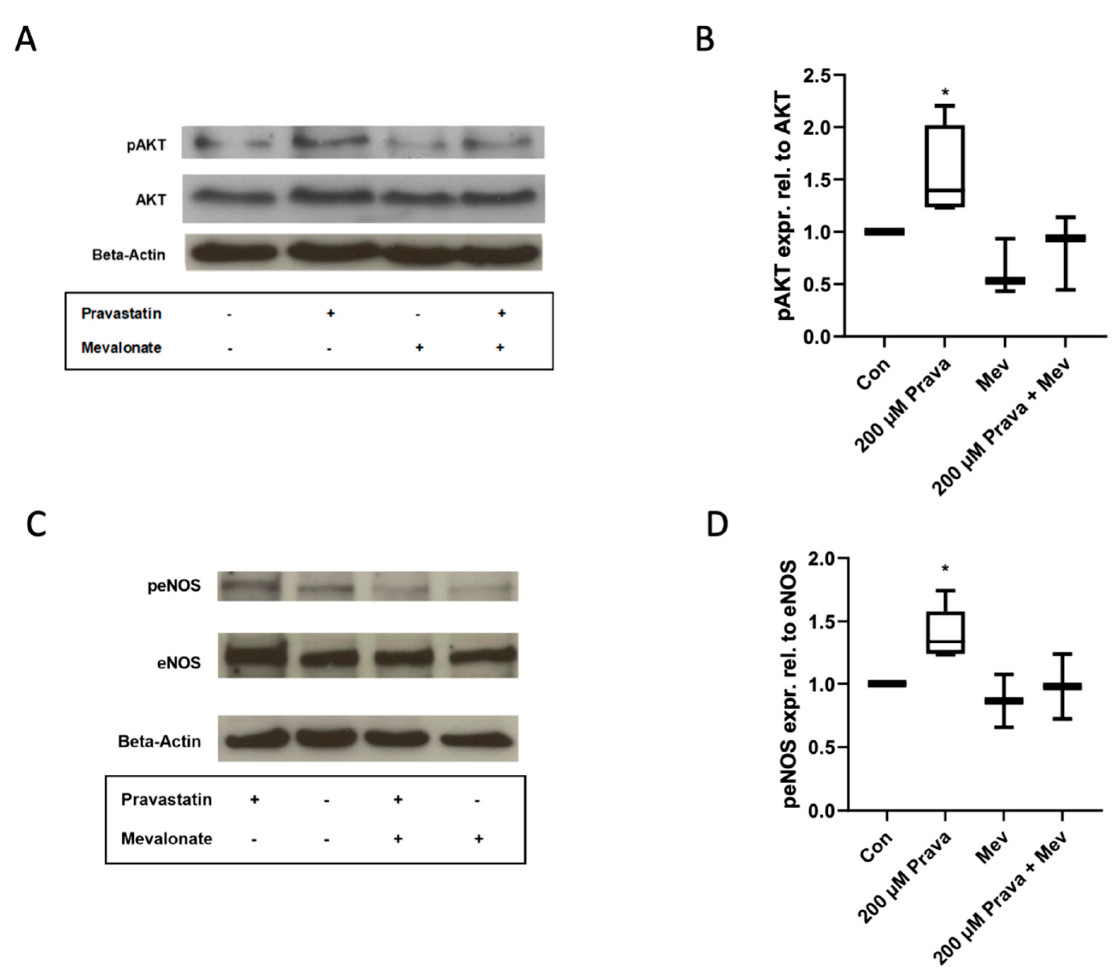
Figure 4. Pravastatin increased phosphorylation of protein kinase B (AKT) and endothelial nitric oxide synthase (eNOS). ( A ) Representative immunoblot of AKT phosphorylation after treatment with pravastatin (200 μ M) in the presence or absence of mevalonate (200 μ M). ( B ) Pravastatin significantly induced AKT phosphorylation, whereas mevalonate abrogates the pravastatin effect. ( C ) Representative immunoblot of eNOS phosphorylation after treatment with 200 μ M pravastatin with or without the addition of mevalonate. ( D ) eNOS phosphorylation was significantly induced after incubation with pravastatin. Mevalonate reversed the pravastatin effect. The effect of pravastatin was investigated in 5 and of mevalonate at least in 2 independent experiments. Con, control; Prava, pravastatin; Mev, mevalonate. * p < 0.05; control group set as 1.